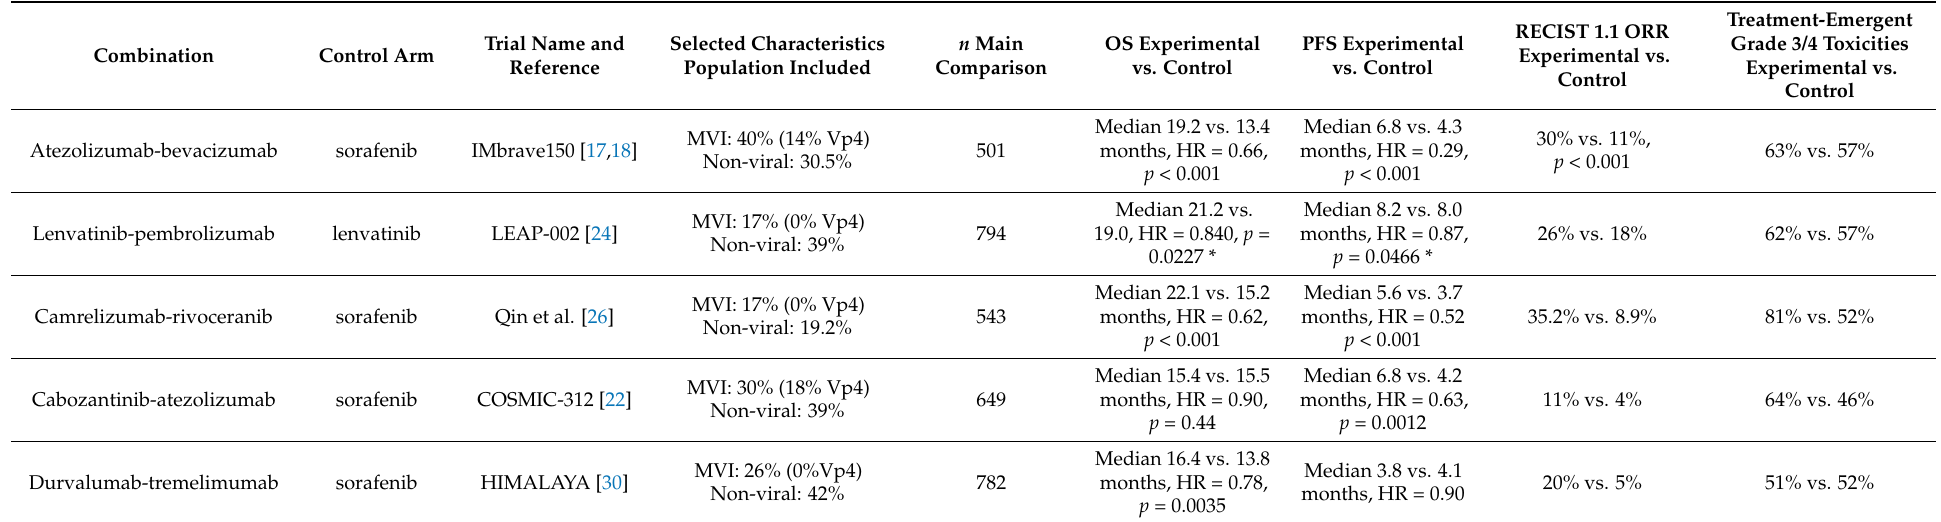
Table 1. Main results of the presented phase III trials of immunotherapy-based combination compared to sorafenib as first-line treatment of hepatocellular carcinoma. OS: Overall Survival; PFS: Progression-Free Survival; ORR (Objective Response Rate); MVI: Macrovascular Invasion; HR: Hazard Ratio; * not statistically-significant per statistical assumptions; Vp4: Tumoral Portal Vein Thrombosis reaching the main portal